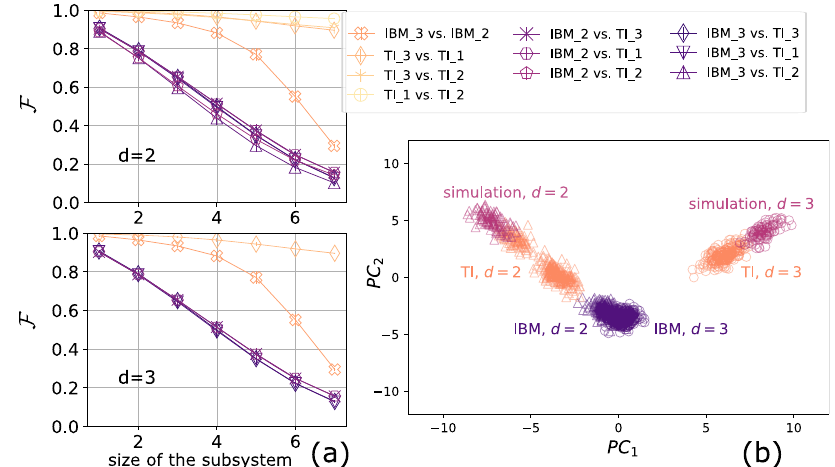
Fig. 3 | The cross-platform fi delity for subsystem and intra-technology simi- larity. a The cross-platform fi delity between subsystems prepared on different quantum computers. Left : 7-qubit quantum volume circuit of two layers. Right: 7-qubitquantum volume circuitof three layers. The meanfor each subsystemsize is calculated via bootstrap re-sampling. b The projection of